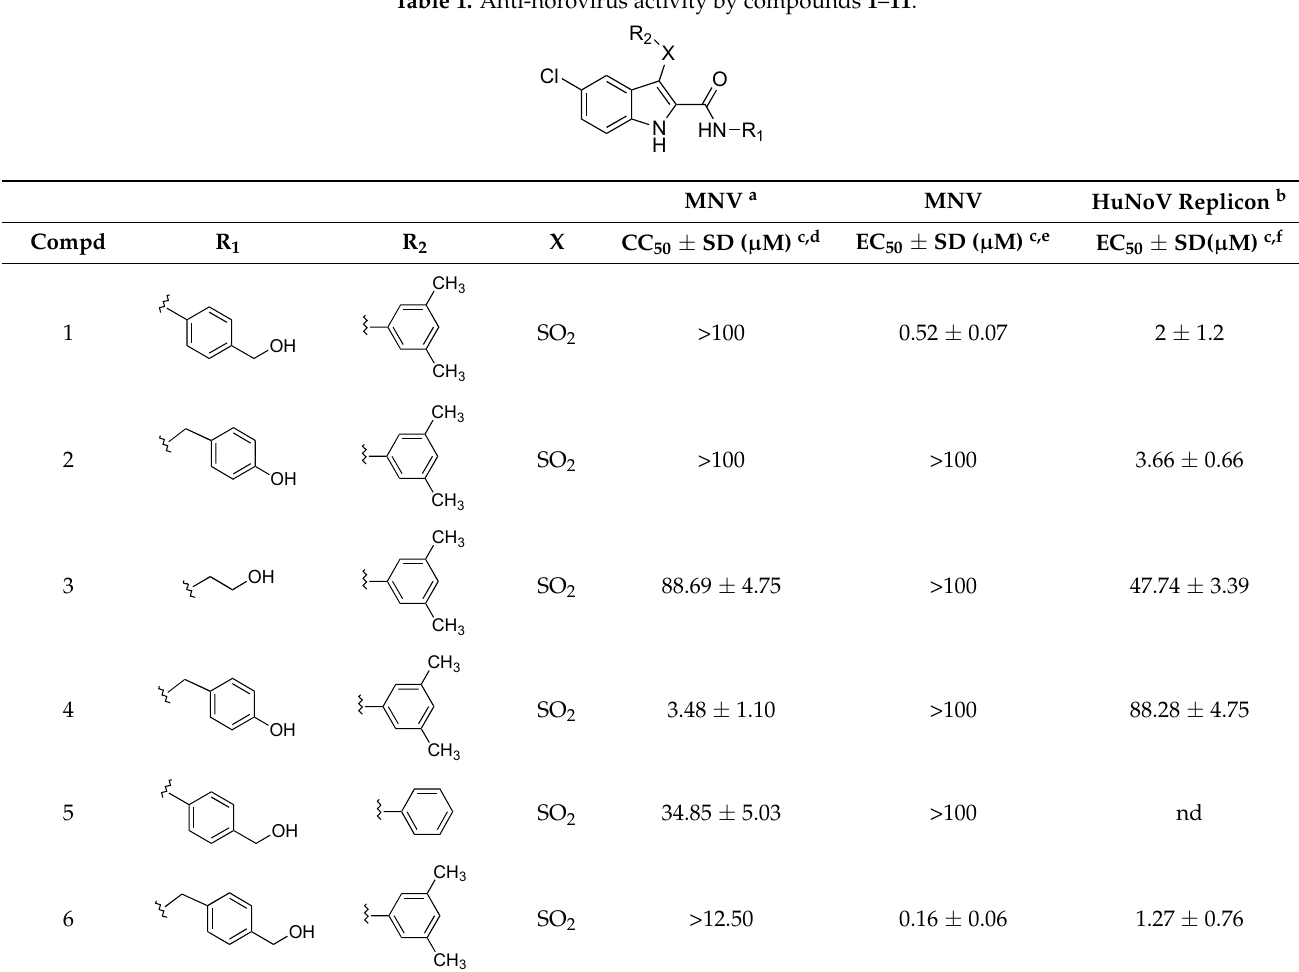
Table 1. Anti-norovirus activity by compounds 1 – 11 .